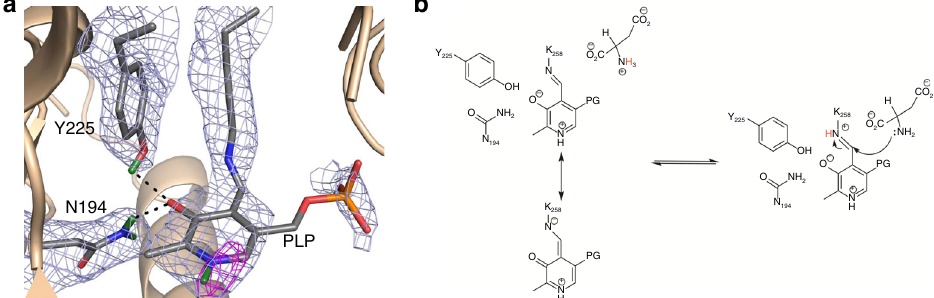
Fig. 2 Internal aldimine reactivity and substrate activation. a Internal aldimine state in the AAT- α -methylaspartate neutron structure. Here and in Figs. 3 and 5, the light blue mesh is the 2 | F o | − | F c | nuclear scattering length density at 1 σ and the magenta mesh is the omit | F o | − | F c | difference nuclear scattering length density at 3 σ . For clarity, the omit | F o | − | F c | difference nuclear scattering maps are presented for deuterium atoms on PLP. The dashed lines indicate hydrogen bonds. b Michaelis complex and proposed substrate activation with the proton transferred upon substrate binding shown in red. A direct or indirect proton transfer mechanism is plausible. Two possible resonance structures of the internal aldimine are shown